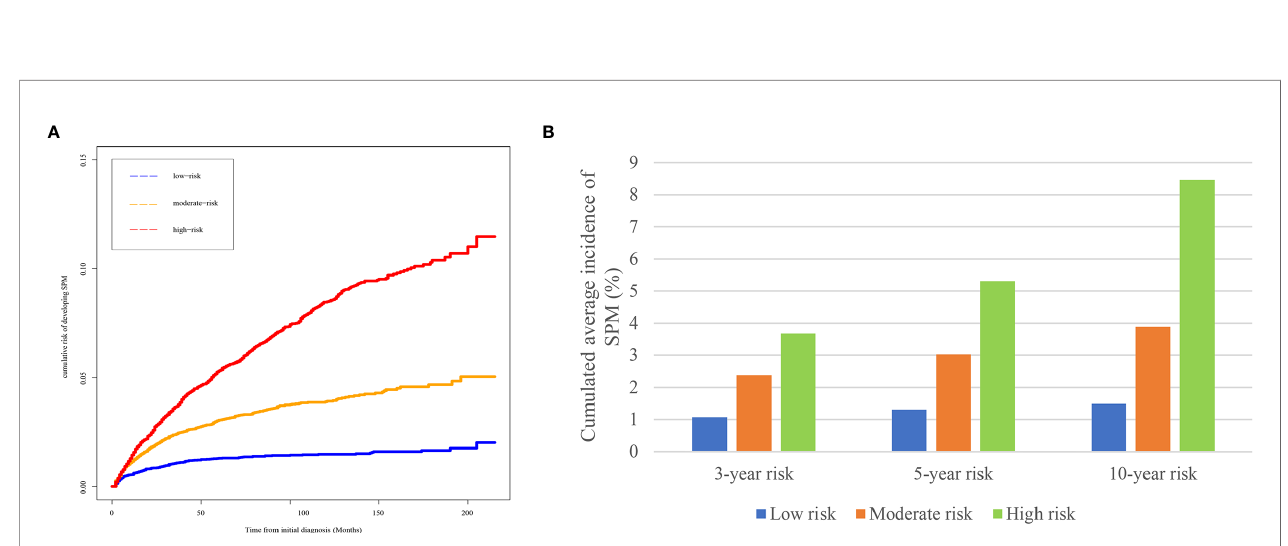
FIGURE 4 | Risk strati fi cation ability of the competing-risk nomogram. (A) Cumulative incidence curves of SPMs among low-, moderate-, and high-risk survivors. (B) Cumulative 3-, 5-, and 10-year incidence of developing SPMs among low-, moderate-, and high-risk survivors. HCC, hepatocellular carcinoma; SPM, second primary